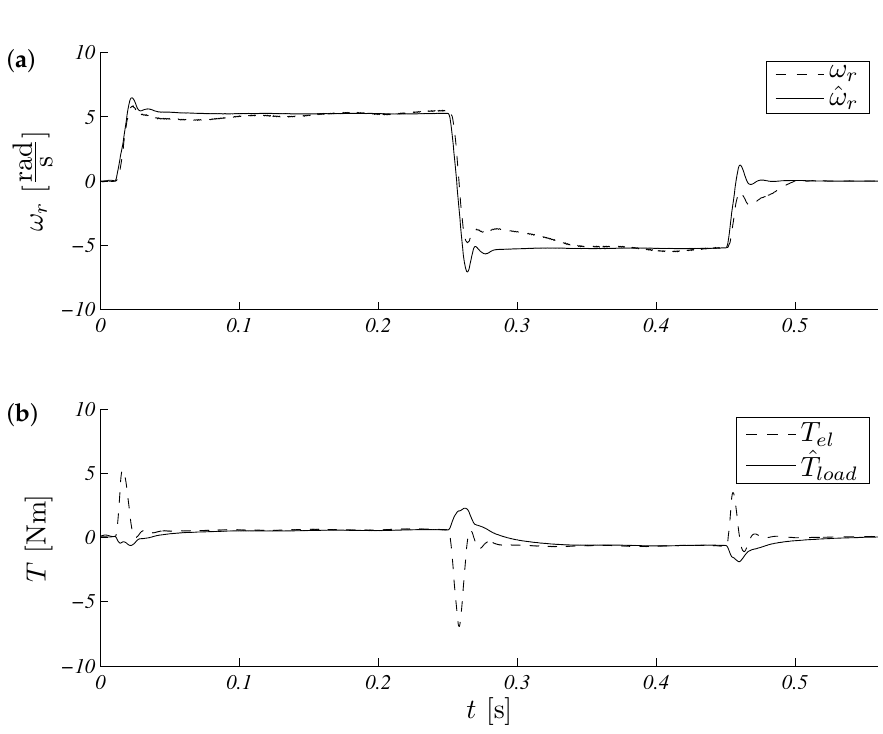
Figure 7. Unscented Kalman filter response speed ( a ) and torque ( b ) for referenced speed ω ∗ r = 5.28 rad